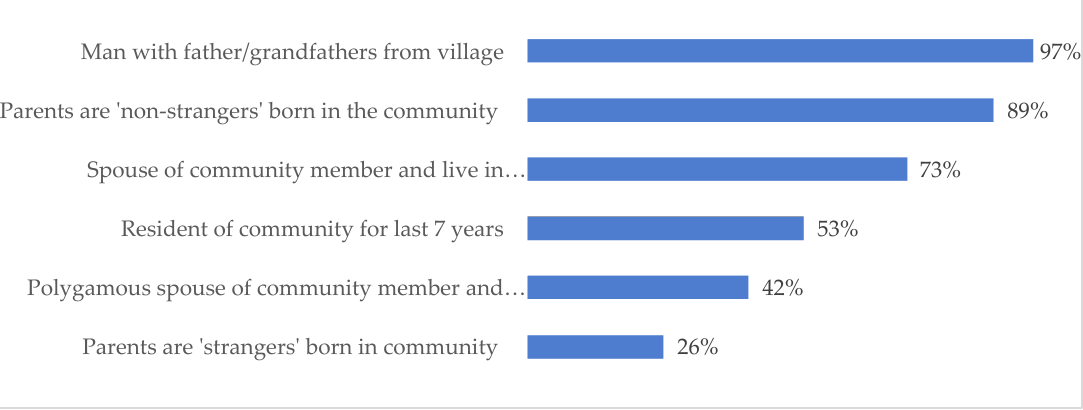
Figure 3. Community Members’ beliefs on the criteria for community membership.